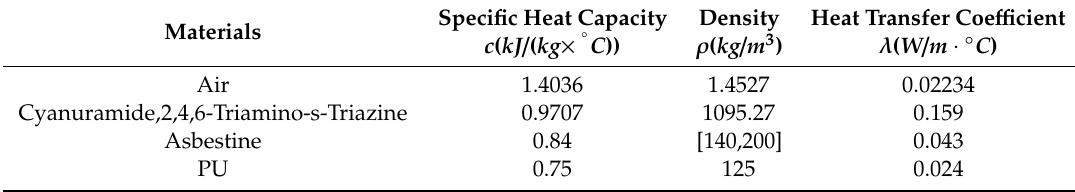
Table 4. Properties of materials in heat conduction